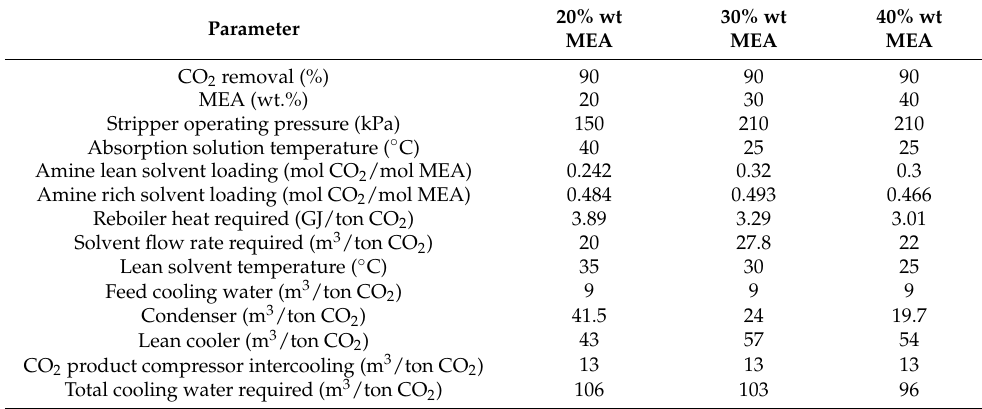
Table 2. CO 2 capture system using amine with different concentrations, adapted from